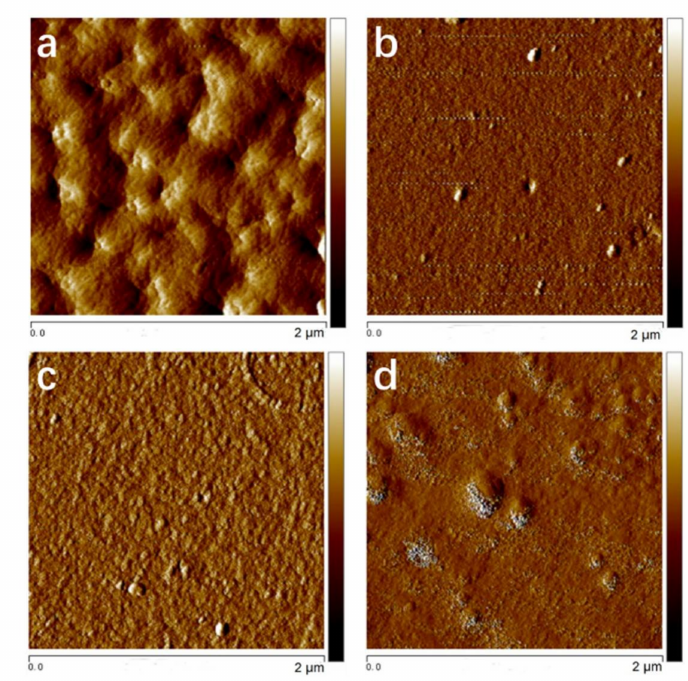
Figure 2. The atomic force microscopy (AFM) images of the structure of composite resins with different POSS additions: ( a ) P00, ( b ) P02, ( c ) P05, ( d )